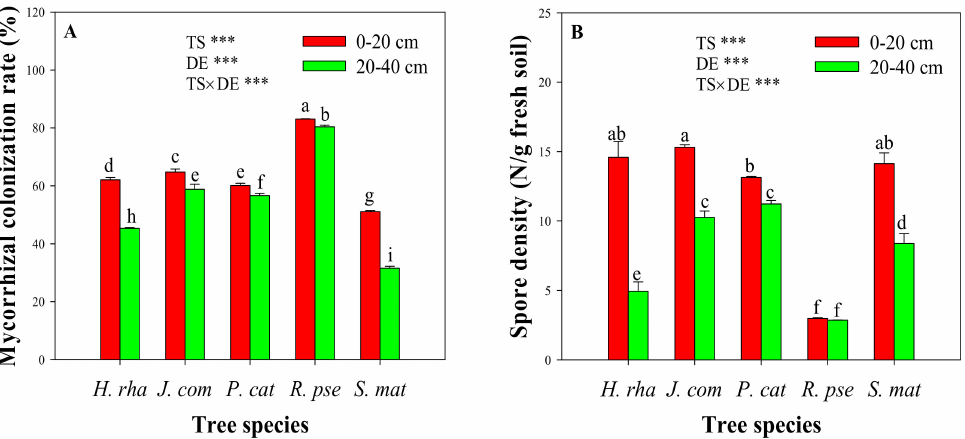
Figure 1. Root colonization ( A ) and spore density ( B ) of arbuscular mycorrhizal fungi in the rhizosphere of five dominant tree species. Two-way ANOVA revealed the e ff ects of soil depth (DE), tree species (TS), and their interactions (TS × DE) on mycorrhizal colonization rate and spore density (*** p < 0.001). Bars represent standard deviation and di ff erent letters on the bars indicate significant di ff erences among the five tree species or between the two soil depths ( p -values < 0.05). Tree species: H. rha , Hippophae